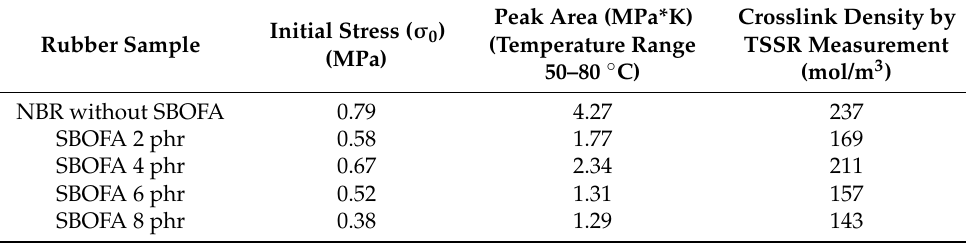
Figure 12. Representative ( a ) stress ( σ 0 ) and ( b ) relaxation spectra H(T) plots as function of temperature for NBR vulcanizates with varying SBOFA loadings. Table 10. Initial stress ( σ 0 ), peak areas in relaxation spectra over the temperature range 50–80°C (Figure 11b), and the crosslink density based on the TSSR analysis for NBR vulcanizates with varying SBOFA loadings.